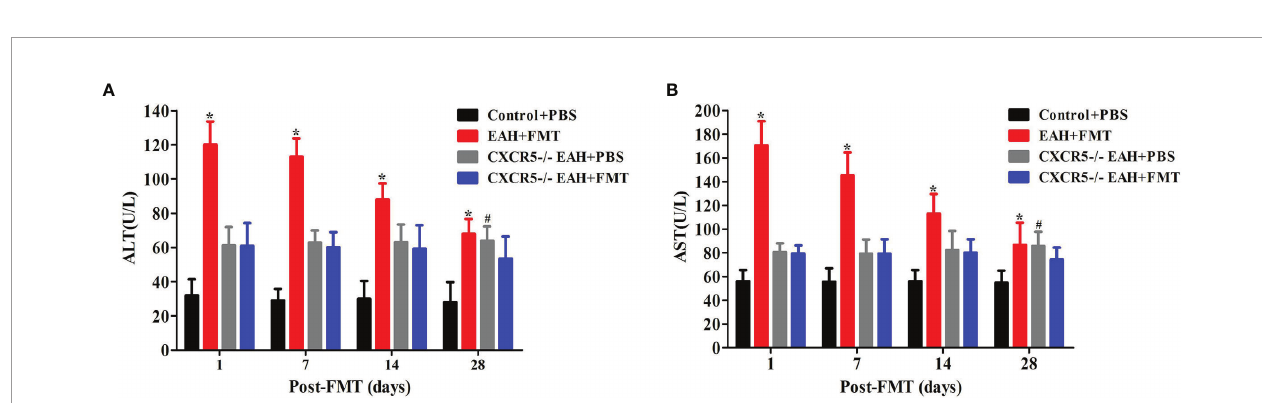
FIGURE 5 | FMT attenuated liver injury in CXCR5 − / − EAH mice . (A, B) Serum ALT/AST levels progressively downregulated from 1 to 28 days in EAH and CXCR5 − / − EAH mice after therapeutic FMT. The horizontal lines indicate the mean values of the different groups. *p < 0.05 vs. control+PBS/CXCR5 − / − EAH+PBS/CXCR5 − / − EAH+FMT; # p < 0.05 vs. control+PBS/CXCR5 − / −